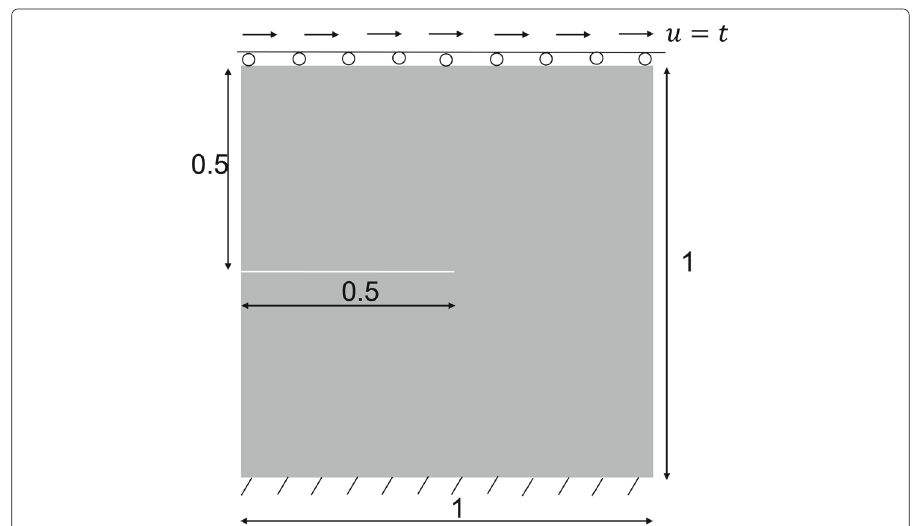
Fig. 7 Geometry, with dimensions in mm, and boundary conditions for the single edge notched shear test. A positive x -displacement and no y -displacement is applied across the top boundary and the x - and y - displacements are fixed on the bottom boundary